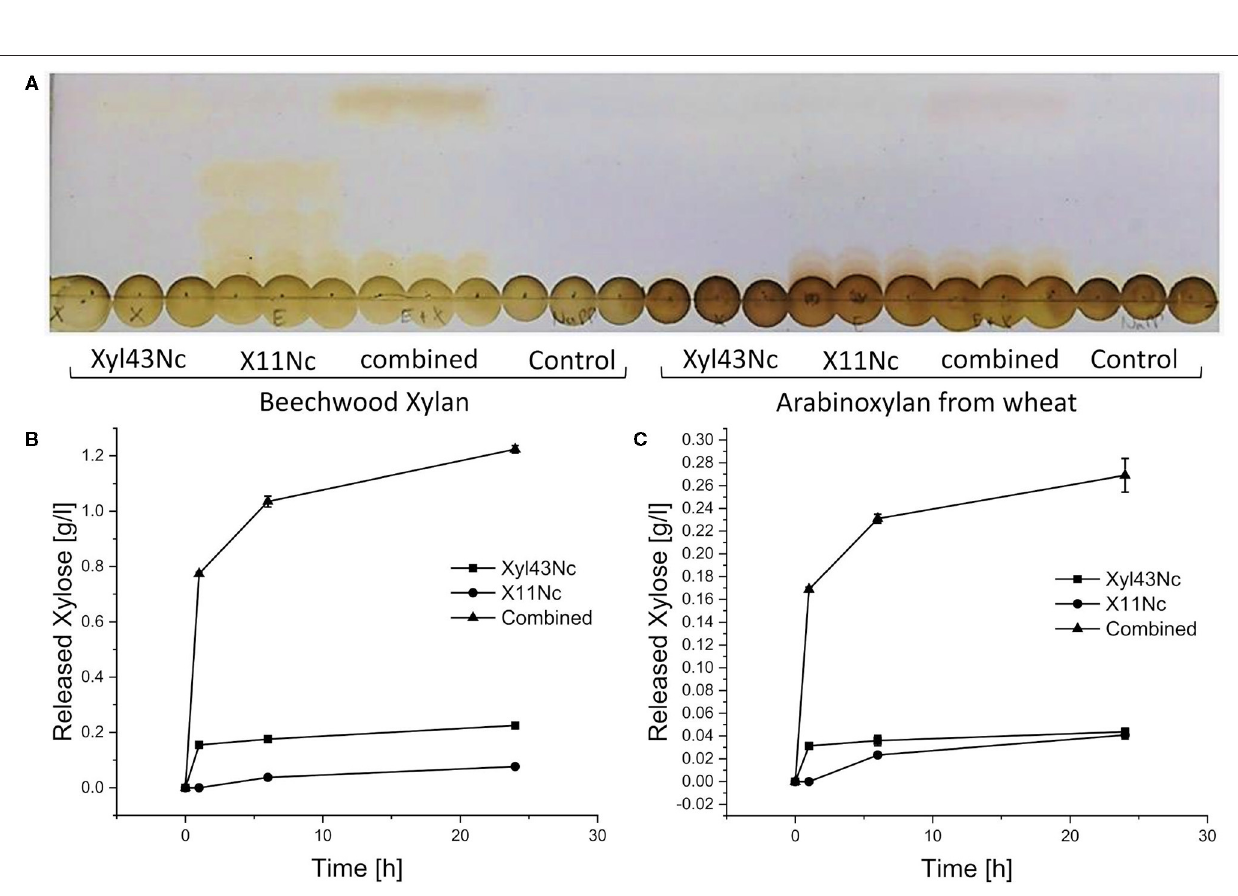
Frontiers in Fungal Biology |